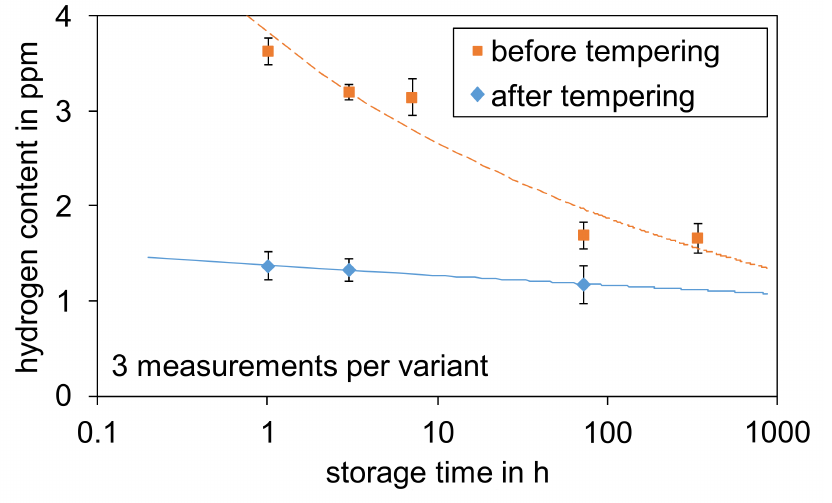
Figure 5. Development of hydrogen content before and after tempering as a function of storage